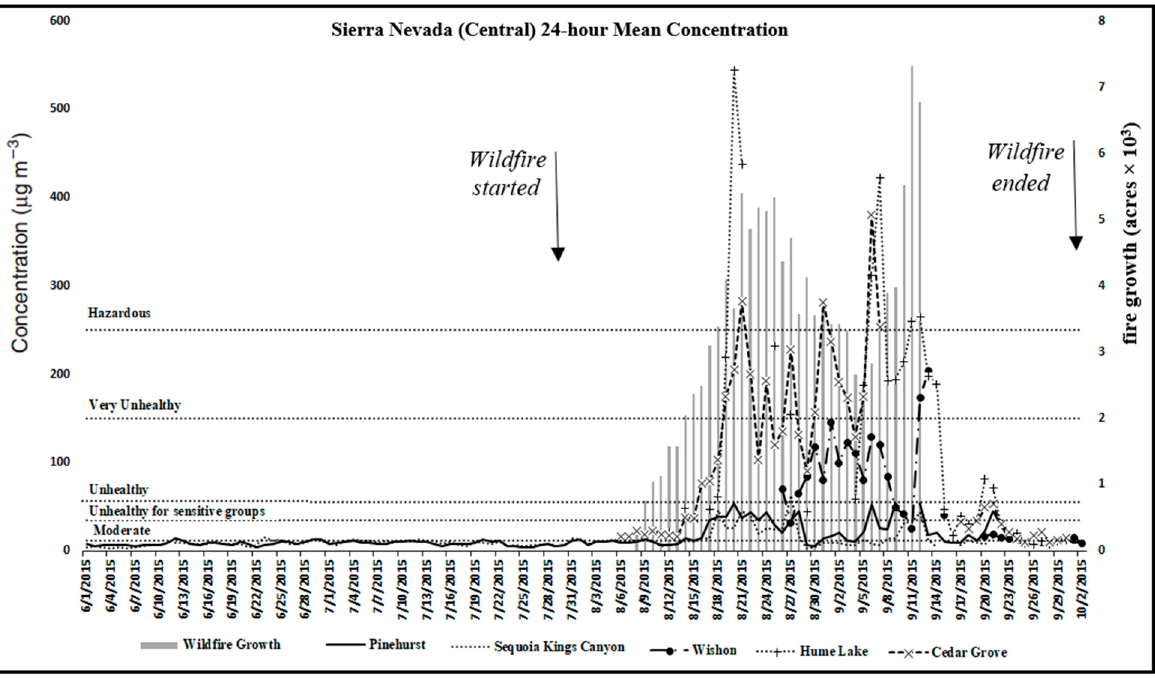
Figure 5. 24-Hour PM 2.5 concentrations with Air Quality Index (AQI) breakpoints for monitoring sites. Note: no daily fire growth data were available at the beginning of the fire.